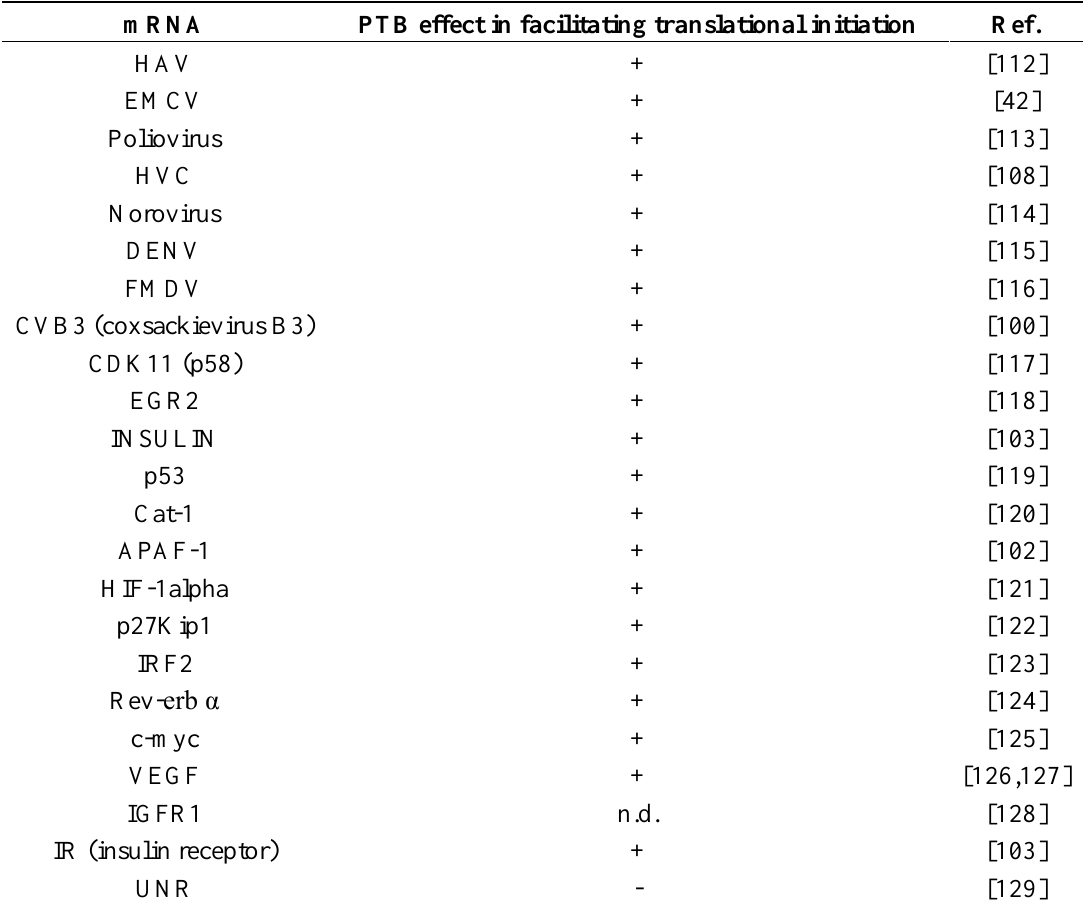
Table 2. IRESs interacting with